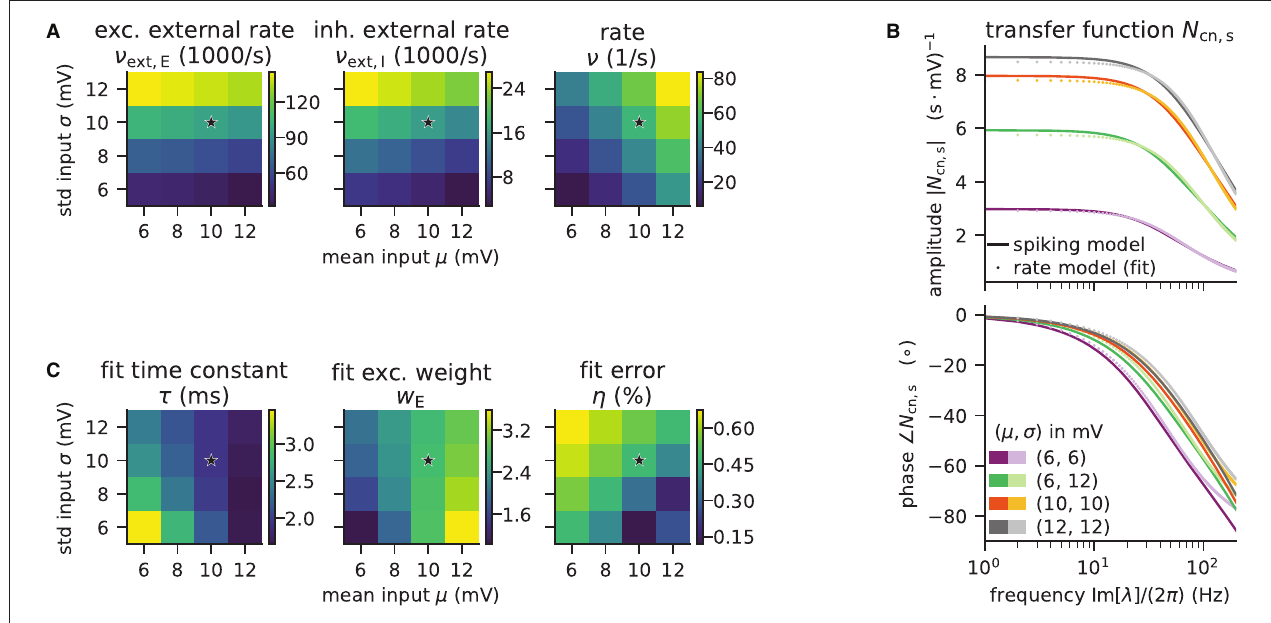
FIGURE 8 | Network parameters and mean-field results from scanning through different working points. Working point (µ , σ) combines mean input µ and noise intensity of input σ . (A) External excitatory ν ext,E and inhibitory ν ext,I Poisson rates required to set (µ , σ) and resulting firing rates ν . (B) Transfer function N cn,s of spiking model and fitted rate-model approximation with low-pass filter for selected (µ , σ) (top: amplitude, bottom: phase). (C) Fit results (time constants τ and gw E with g excitatory weights w E ) and fit errors η . The inhibitory weights are w I 5. Star marker in panels (A) and (C) denotes target working point ( 10, 10 ) mV. = − = Similar displays as in Senk et al. (2020, Figure